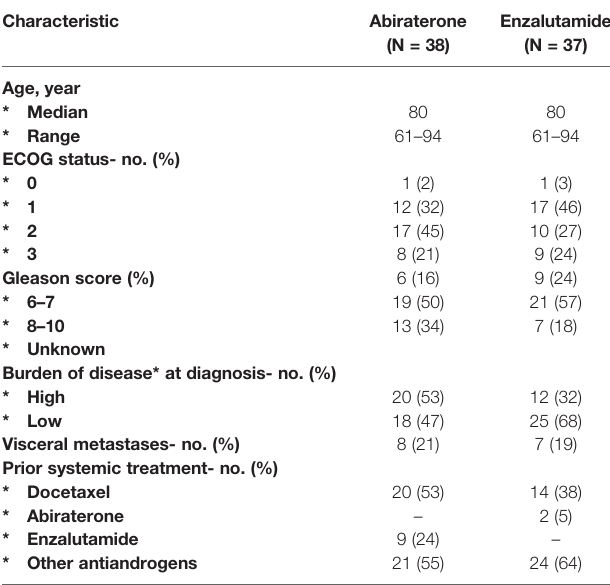
TABLE 1 | Baseline patient and disease characteristics in the abiraterone and enzalutamide groups.